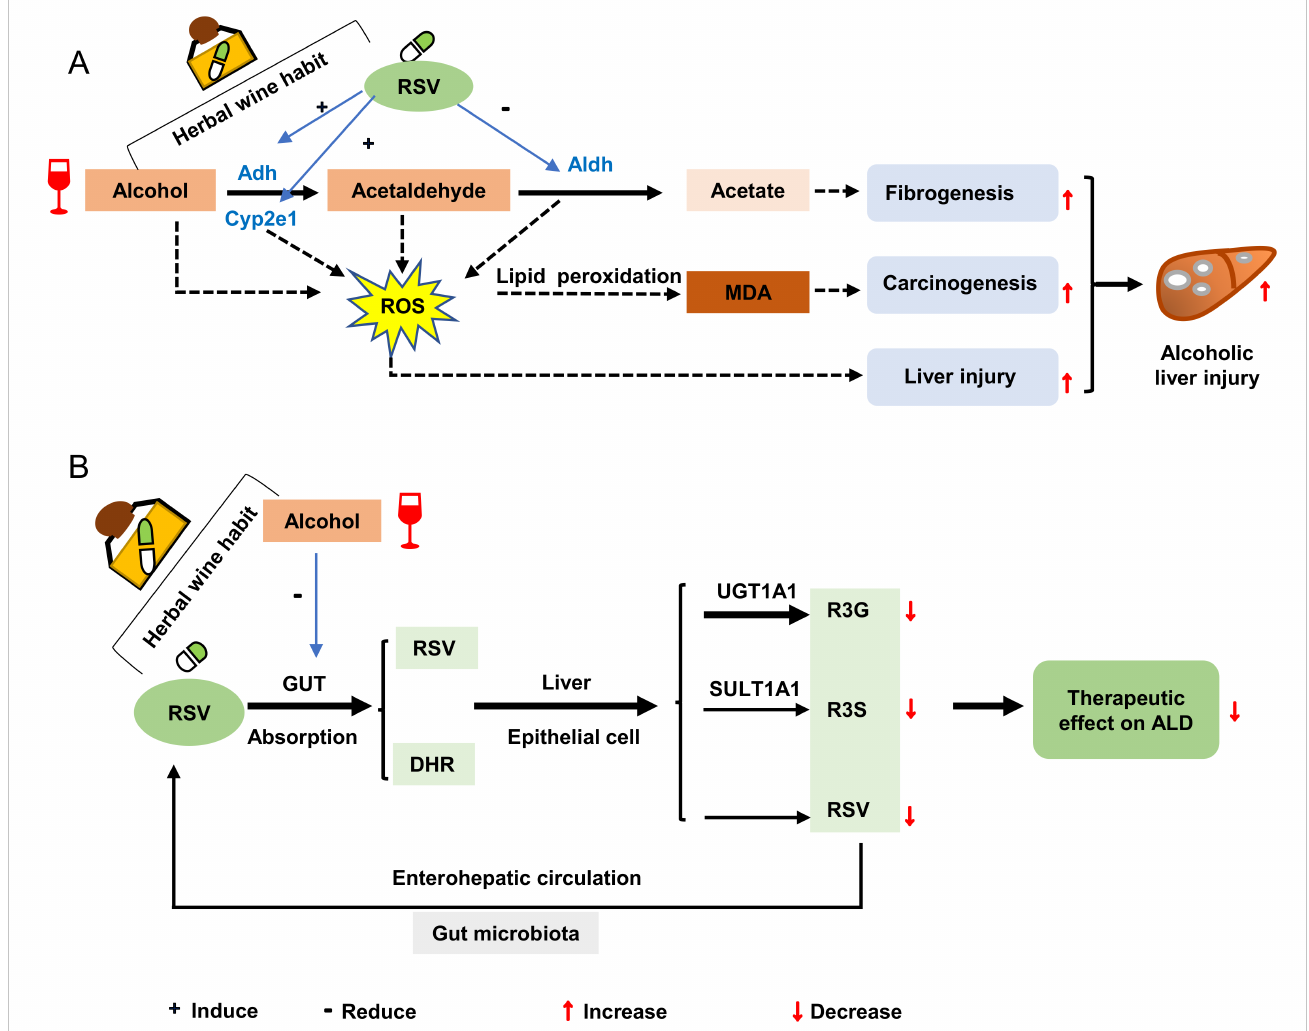
Figure 5. Influence of RSV − alcohol interaction when drinking herbal wine habit regularly. ( A ) Resveratrol in liquor exacerbates alcoholic liver injury through herbal wine habit administra- tion. ( B ) Alcohol reduces the therapeutic effect of resveratrol on ALD through herbal wine habit administration. + : induce; - : reduce; ↑ :increase; ↓ :